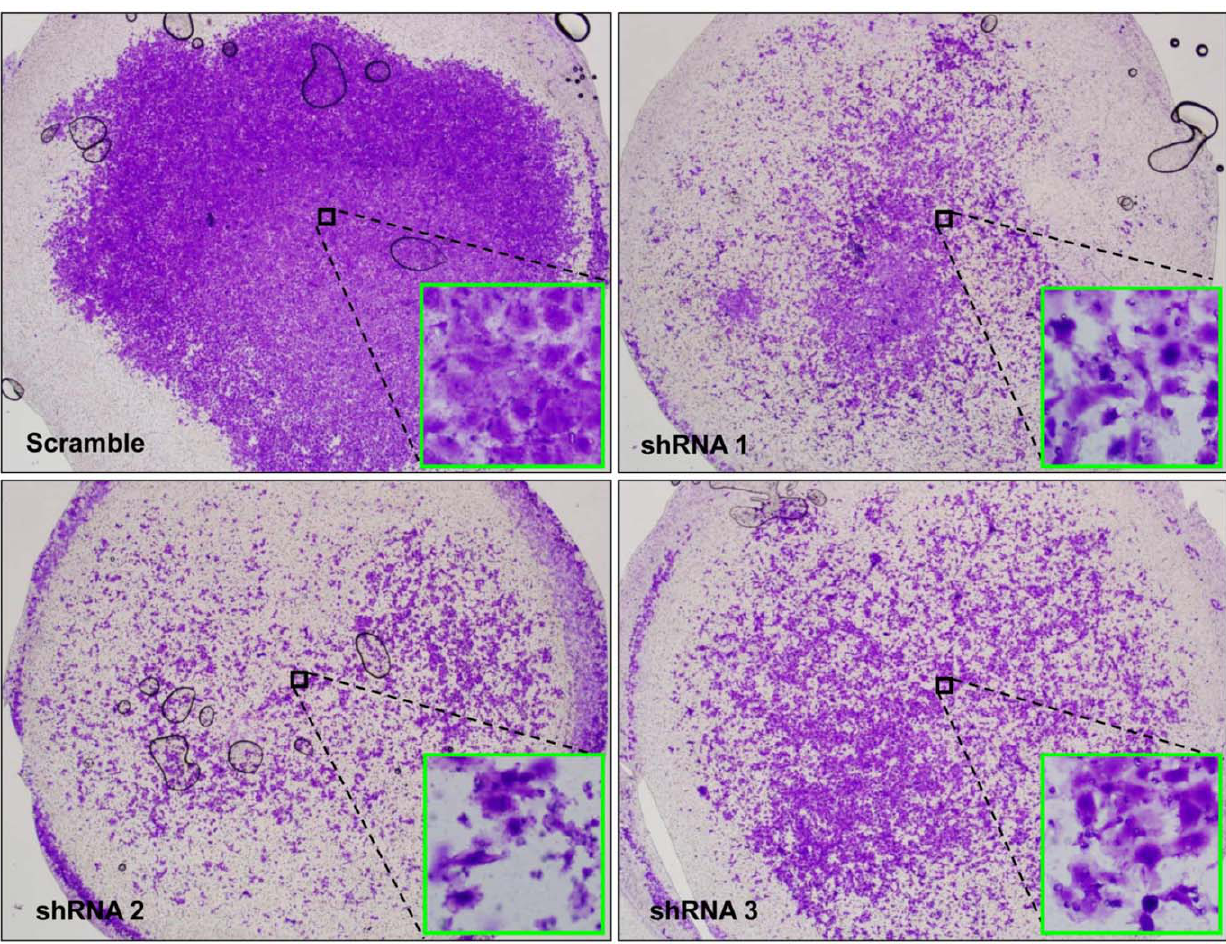
Figure 3. SBSN is important in maintaining invasion and metastatic capability in SACC83. Matrigel invasion assay was performed with scramble control and three types of SBSN shRNA stable clones made from SACC83, as indicated by scramble, shRNA 1, shRNA 2, and shRNA 3. Representative photos of whole transwell membranes are pictured at 4 6 magnification; the inset pictures were taken at 20 6 magnification at randomly selected central locations. This metastasis analysis was performed in triplicate.